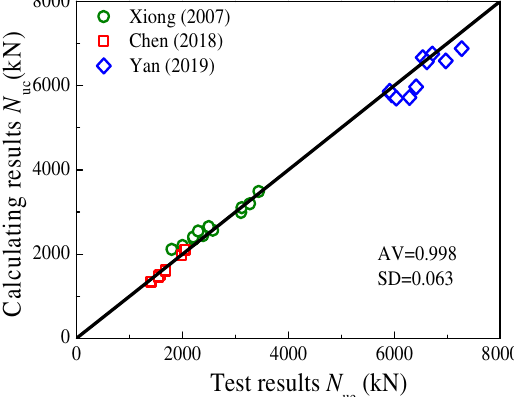
Figure 15. The comparison of predicted N uc in this work with test results. (Chen et al. [33], Xiong et al. [34], Yan et al. [41])